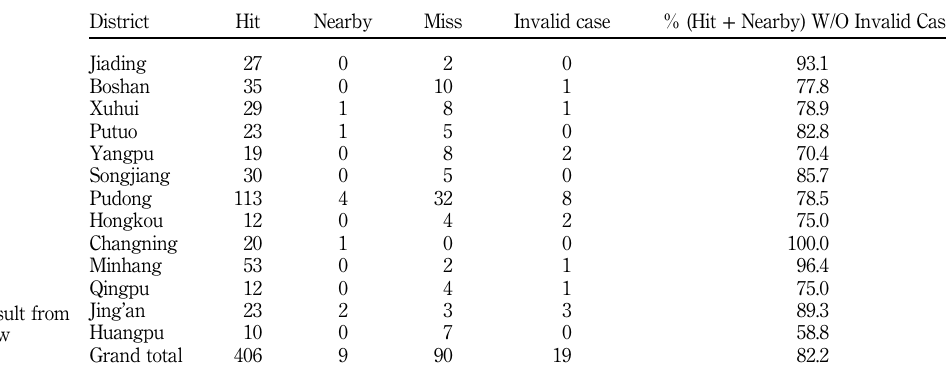
Table VI. Validation result from manual review (by